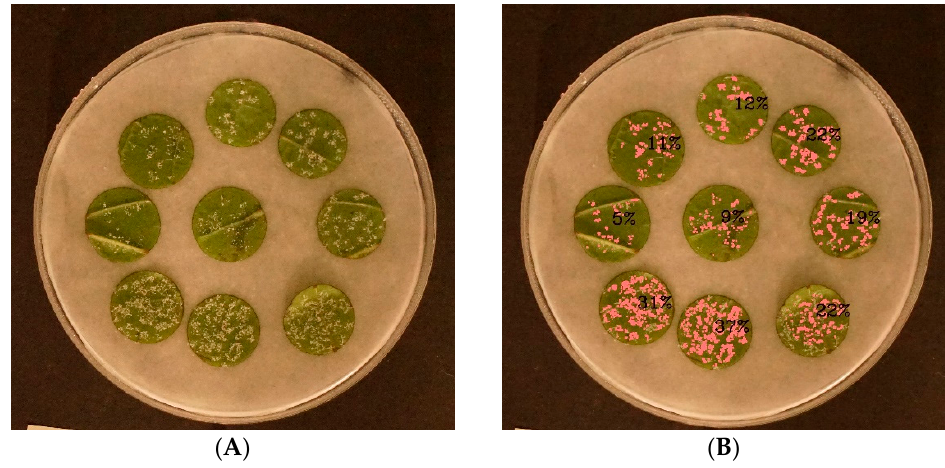
Figure 3. Assessment of downy mildew severity in grapevine leaves by computer vision. ( A ) origi- nal RGB image, ( B ) processed image with quantified downy mildew sporulation in leaf discs.